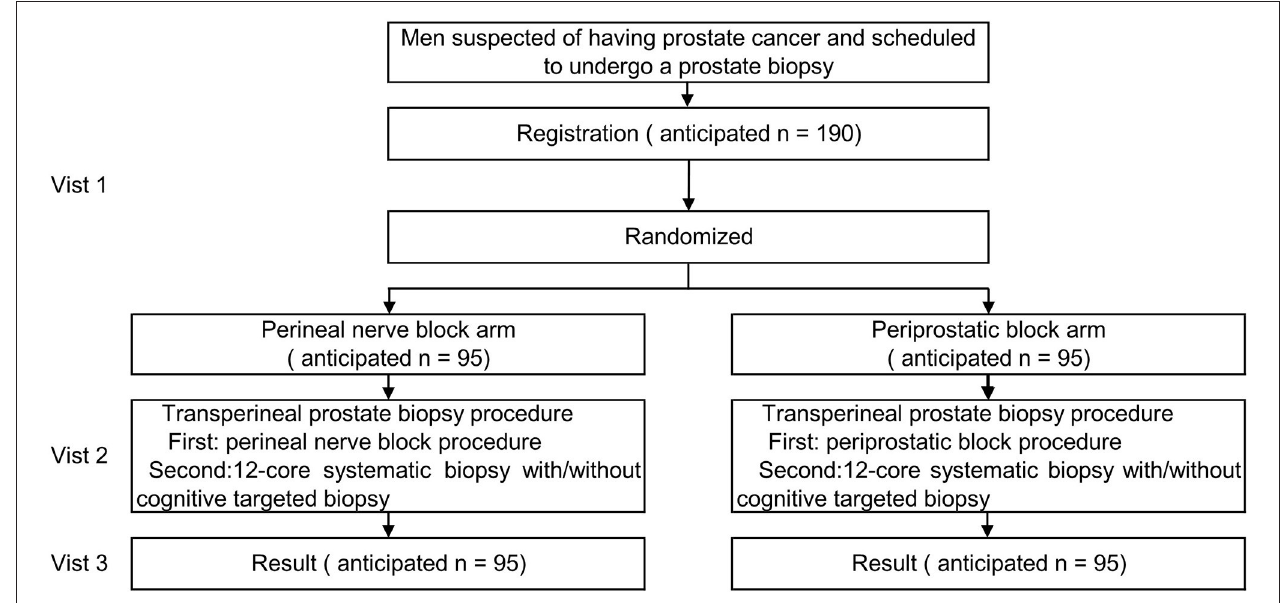
FIGURE 1 | Trial flow chart.